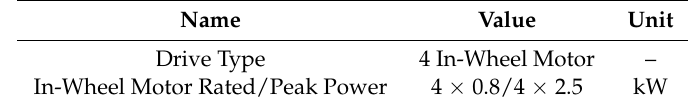
Figure 7. Relationship between torque, rotating speed, and efficiency. Table 6. Electric motor values.